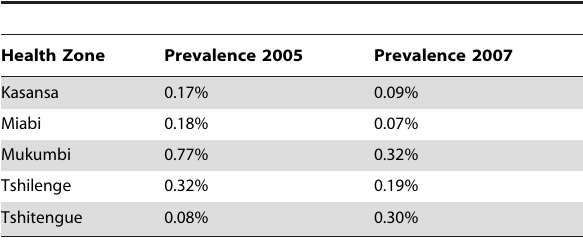
Table 1. Prevalence data for the health zones included in the study.